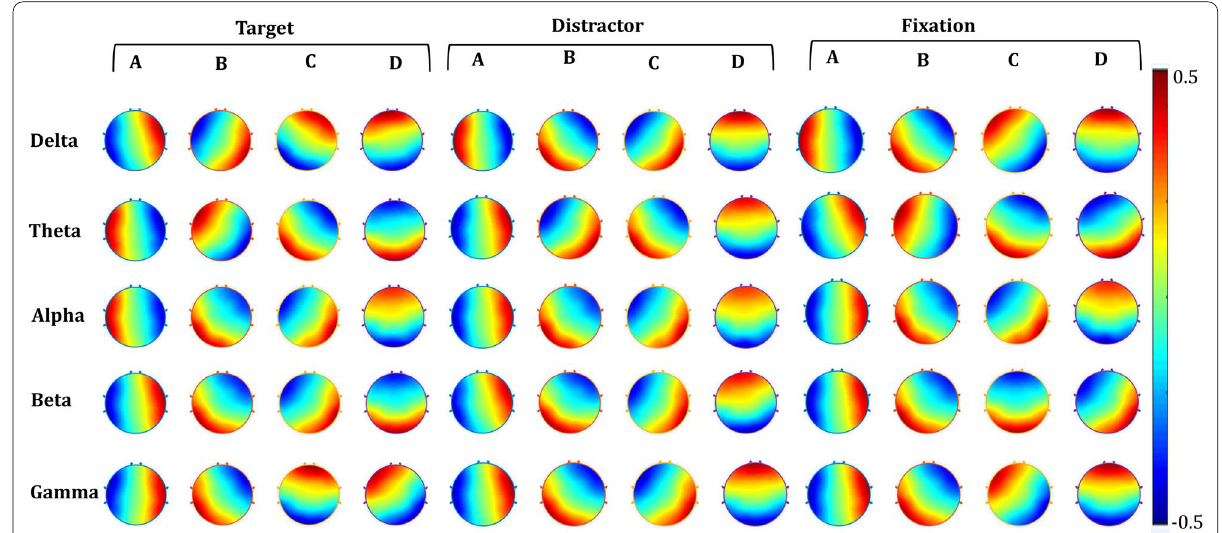
Fig. 4 A topographical representation of frequency-microstates for the target, distractor, and